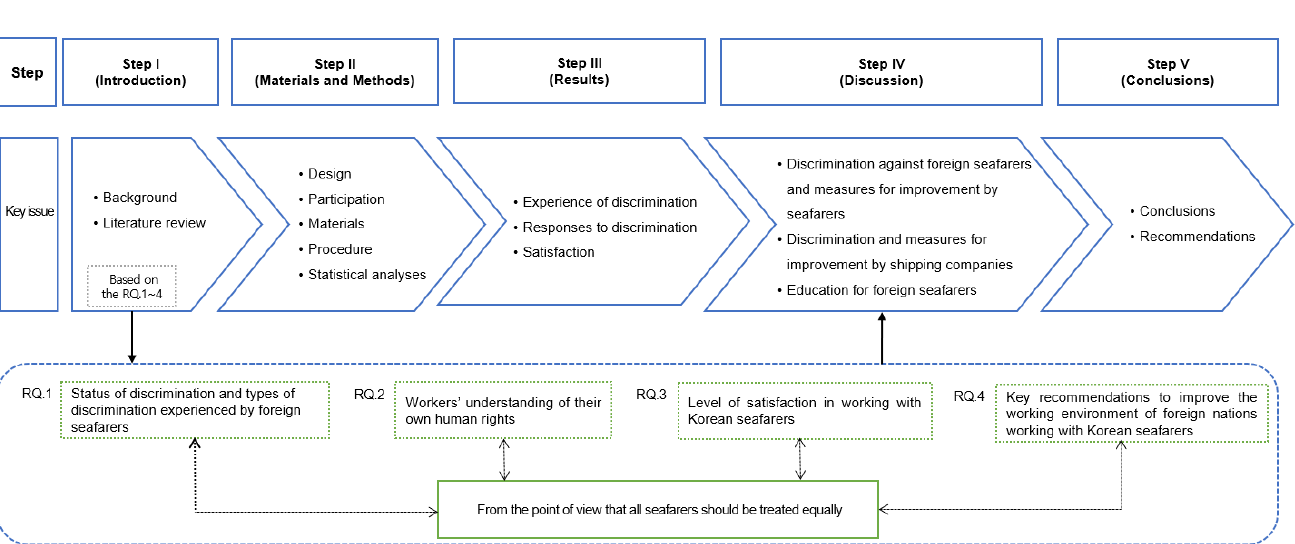
Figure 1. Study Design and Process.